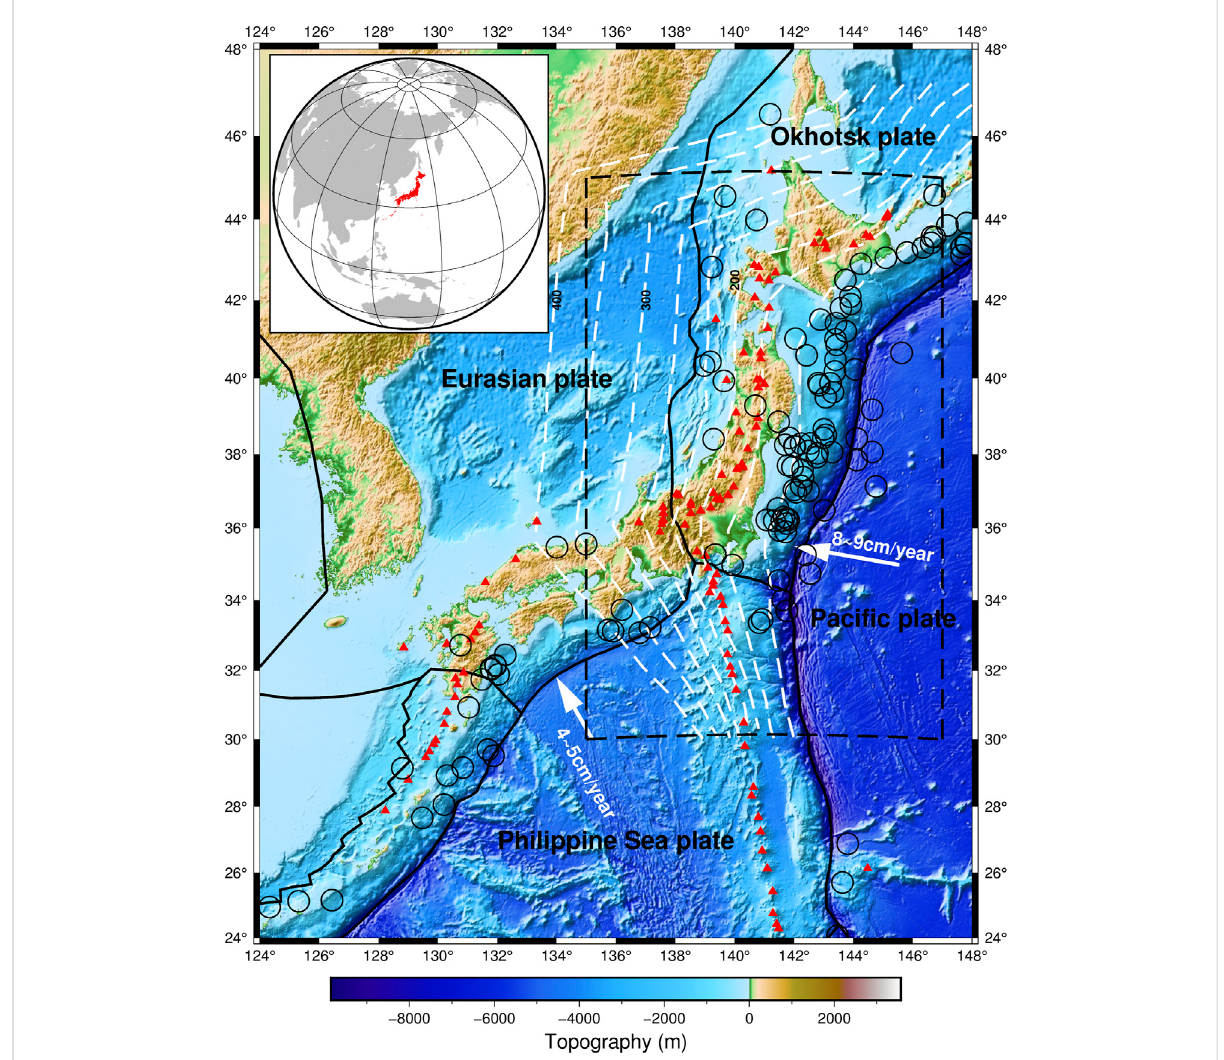
FIGURE 1 Seismicity in the study region (black pane) and surrounding regions. Major tectonic units are labeled, including the Paci fi c Plate, Philippine Sea Plate, Eurasian Plate, Okhotsk Plate. The solid white arrow represents the subduction direction of plate. The red triangles denote the active arc volcanoes. Plate boundary data are from Bird (2003). The white dotted line represents the depth of the subducting Paci fi c plate (Zhao et al., 2012). The top left sub-map represents the location of the island of Japan in the